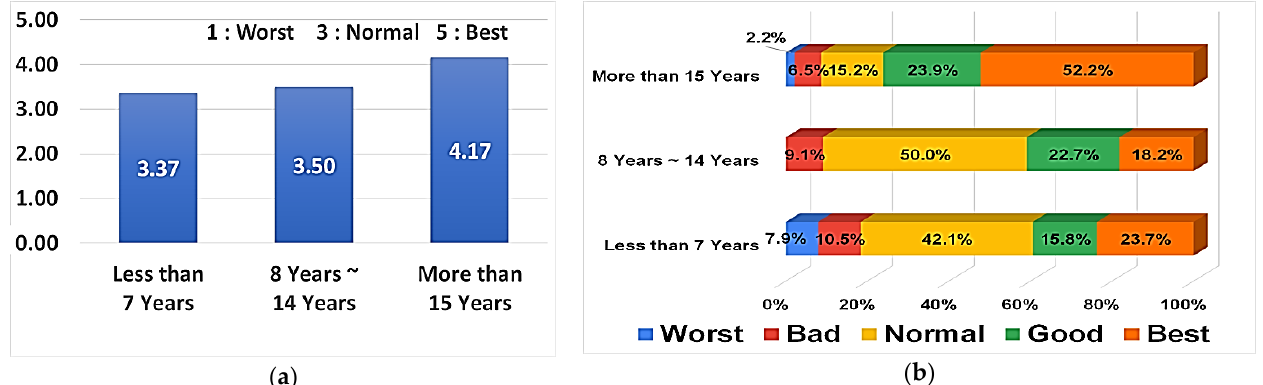
Figure A7. ( a ) Users’ understanding of the term ‘MENU’ by experience of GPS plotter usage. Average (1: Worst to 5: Best); ( b ) distribution of respondents (percentage).